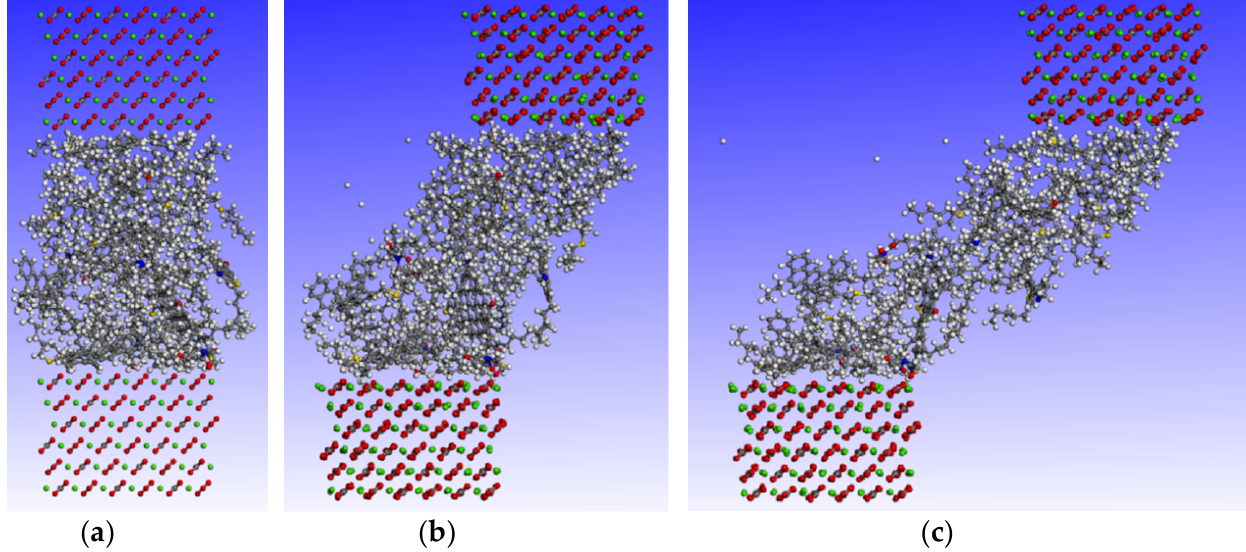
Figure 5. The configuration of friction system at different times under shear rate of 20 m/s (( a ) 0 ps; ( b ) 50 ps; ( c ) 100 ps).